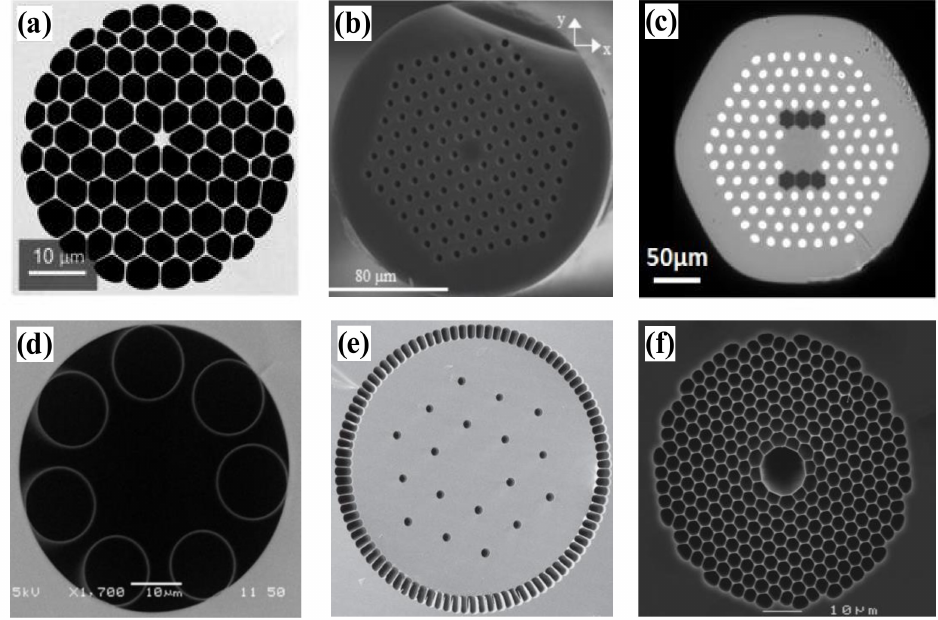
Figure 2. Microstructural arrangement of PCFs. ( a ) Total internal reflection (TIR) [11]; ( b ) Total internal reflection (TIR) [12]; ( c ) Polarization-Maintaining Photonic Crystal Fiber [13]; ( d ) Hollow-core anti-resonant (HC-AR) PCFs [14]; ( e ) Solid-core large-pitch photonic crystal fiber [15]; ( f ) Hollow-core photonic bandgap fibers (HC-PBGFs)